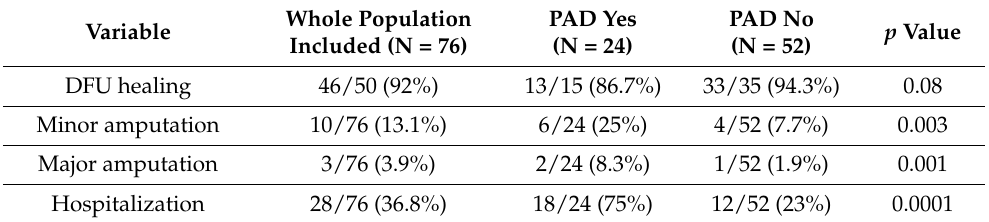
Table 4. Outcomes of interest at 24 weeks.